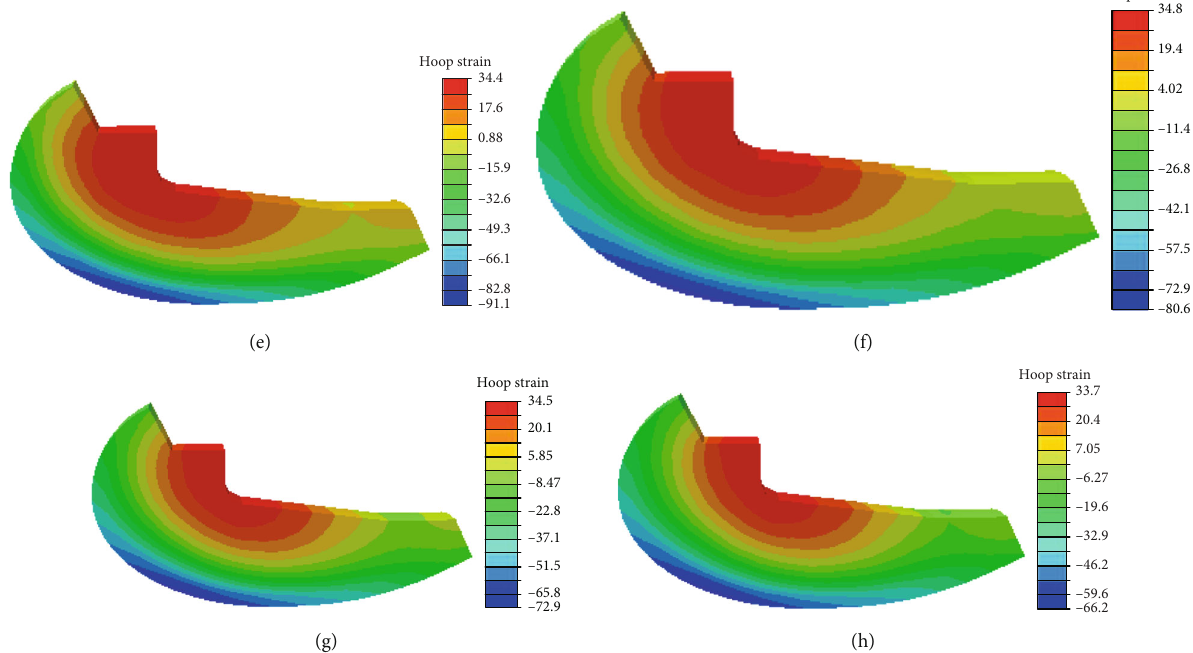
Figure 10: Hoop stress of throat insert at di ff erent times: (a) at 1.3s, (b) at 4.1s, (c) at 6.1s, (d) at 10.1s, (e) at 15.1s, (f) at 20.1s, (g) at 24.1, (h) at 28.0s, MPa.